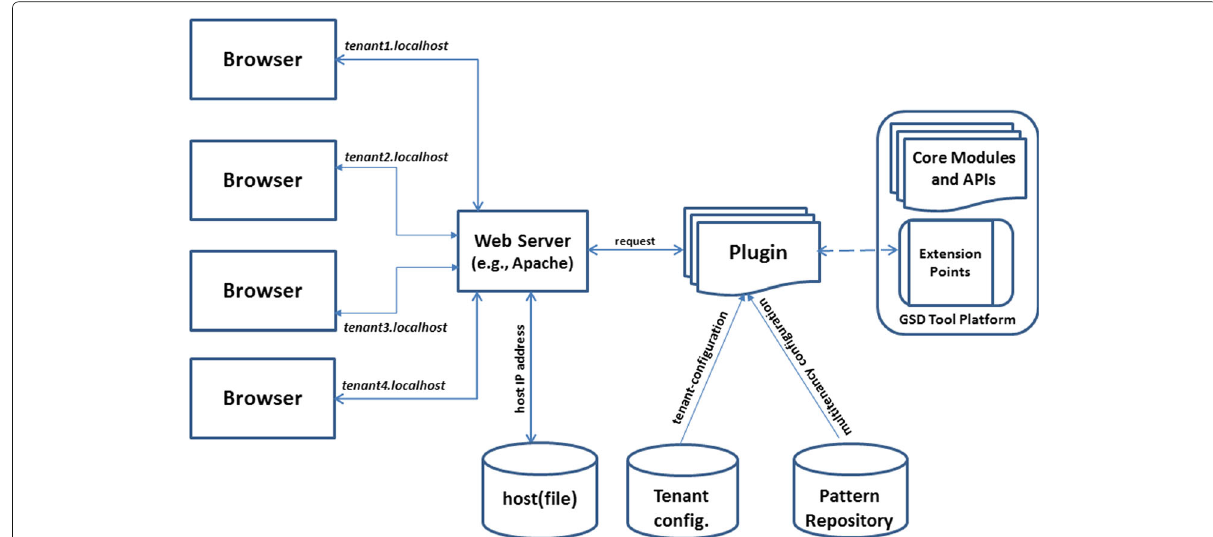
The results of the study were analysed using relevant statistically techniques. We adopted the Repeated Mea- sures Design and Two-way Repeated Measures (within- between) ANOVA for the experimental design and statistical analysis respectively [28,